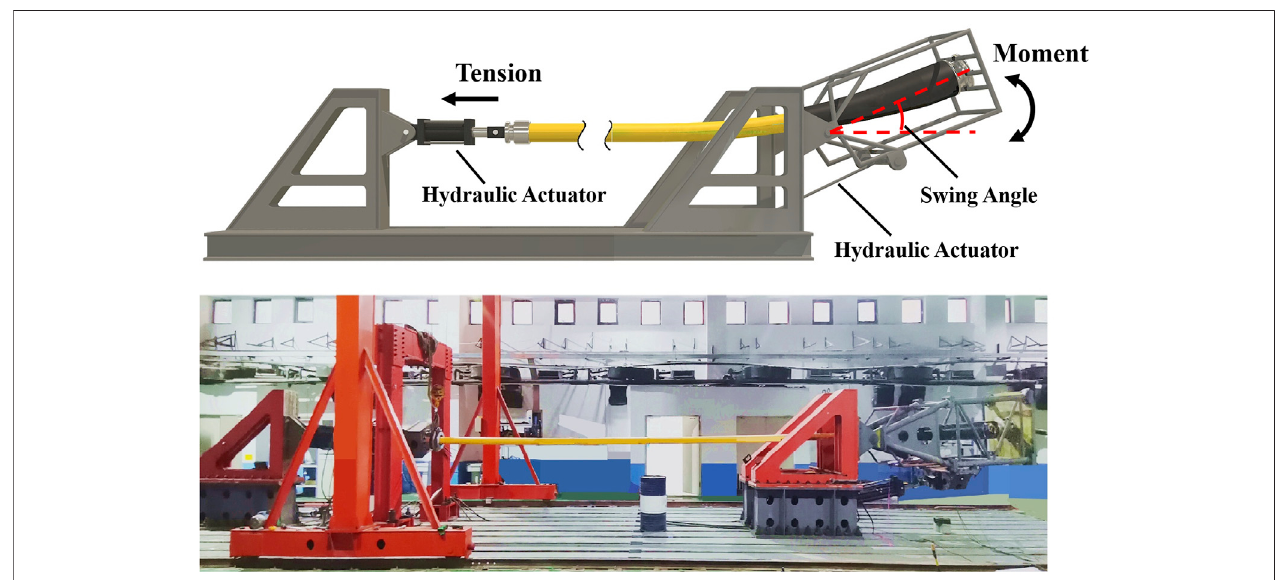
FIGURE 3 | Schematic and picture of the test rig.